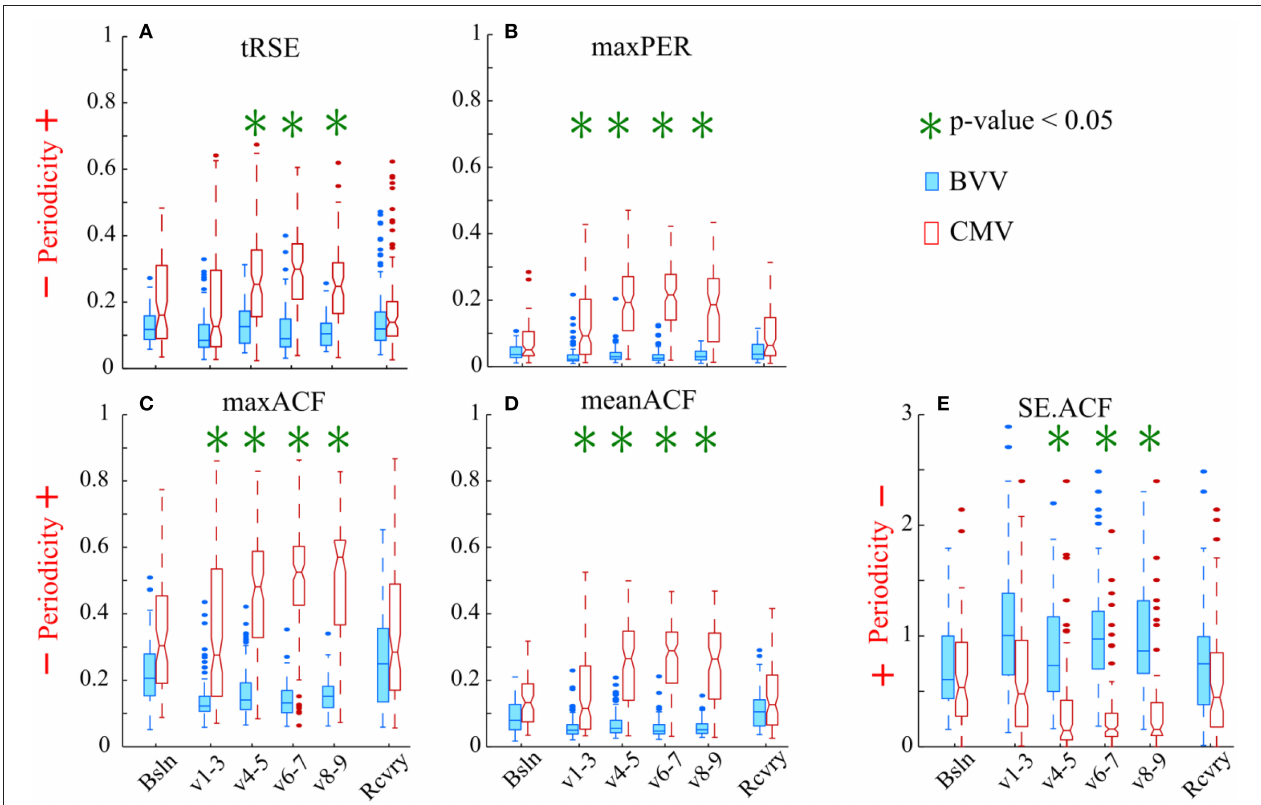
FIGURE 5 | Variability of the RR intervals was greater during BVV than CMV by our measures of periodicity in the autocorrelograms. The box-and-whisker plots display the values for: (A) tRSE, (B) maxPer, (C) maxACF, (D) meanACF, and (E) Sample entropy of the acutocorrelation function (SE.ACF). (A–D) For these indices values closer to 1 indicate stronger periodicity. (E) Values of SE.ACF closer to zero have decreased probability in predicting the occurrence of the next heartbeat. We analyzed sequential RR intervals from baseline (Bsln), ventilation (V1-3, V4-5, V6-7, V8-9), and recovery (Rcvry) periods for BVV and CMV treated groups. HRV was significantly different during the two type of ventilation. HRV was not significant different during baseline and